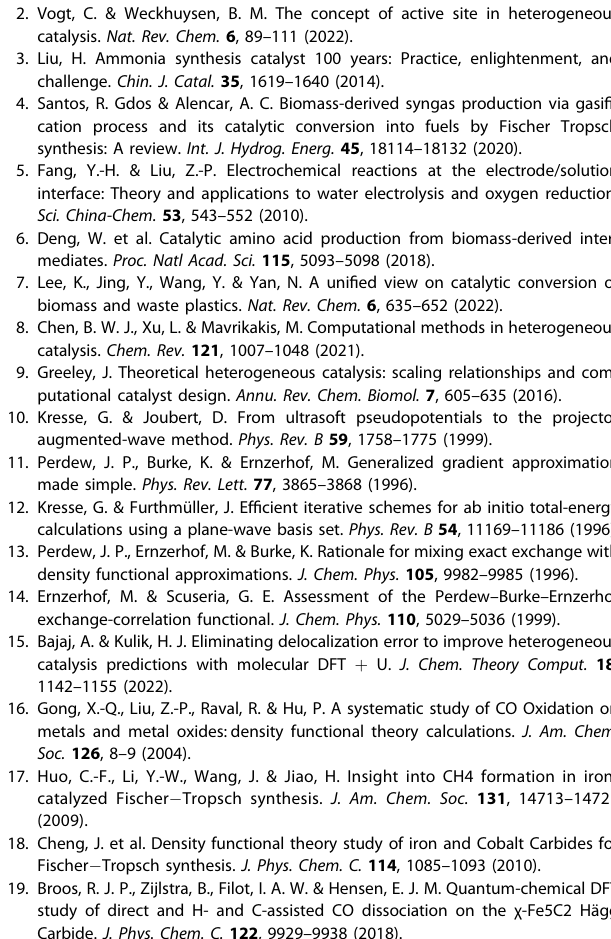
Fig. 6 The MMLPS method and its application. a Contour plot for 14958 reaction pair (IS, TS, FS) obtained by MMLPS on Cu(211). b CO 2 and c CO hydrogenation Gibbs energy pro fi le on Cu and Zn alloyed Cu surface. Reproduced with permission from ref. 117 . Copyright American Chemical Society,